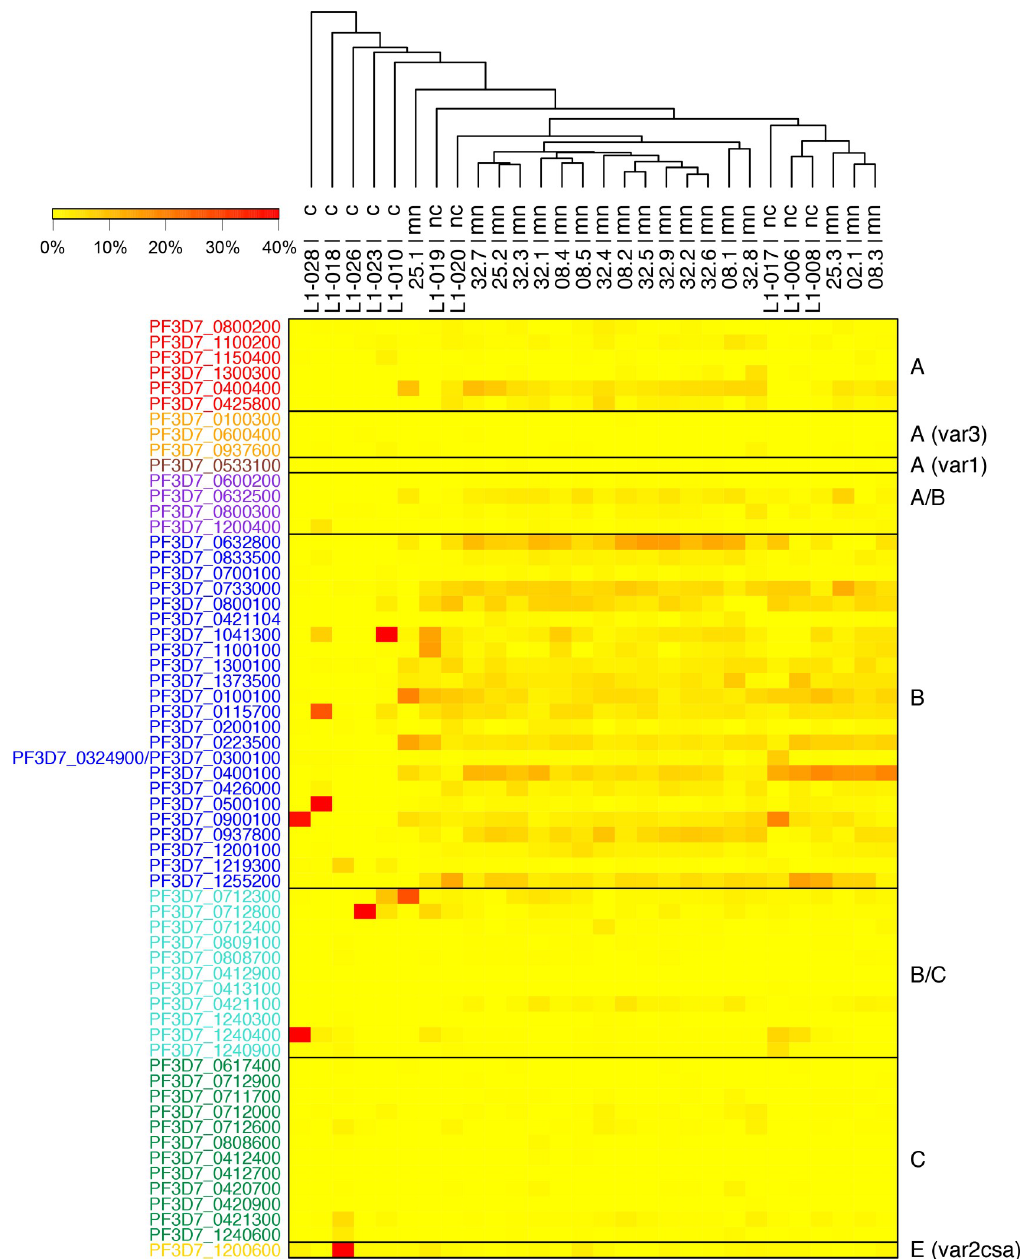
Fig 2. Patterns of var transcript level in malaria-na ï ve [37] and lifelong malaria-exposed adults sampled prior treatment. Heat map showing the individual var transcript profiles for all volunteer samples taken immediately before treatment was initiated. To correct for individual differences in the overall var transcript levels, the level for each var gene was normalized against total var transcript level in each sample. Hierarchical cluster analysis confirms that the subgroups of malaria-na ï ve (mn), ‘non-controller’ (nc) & ‘controller’ (c) volunteers are characterized by different var transcript patterns. Volunteers IDs of malaria-na ï ve samples according to [37]. Annotations of var gene variants are indicated on the left side, var gene group affiliations are indicated by the color code with A-type var genes in red, the subfamilies var3 and var1 in orange and dark red, B/A genes in purple, B-type genes in blue, B/C genes in turquoise, group C genes are colored in green and the var2csa gene (group E) is shown in